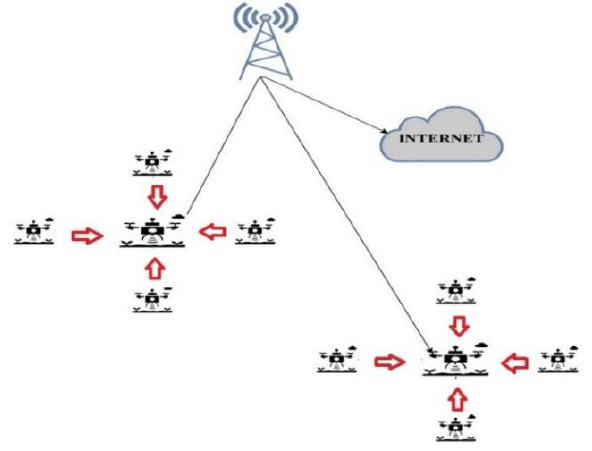
Figure 2. Basic FANET Structure.